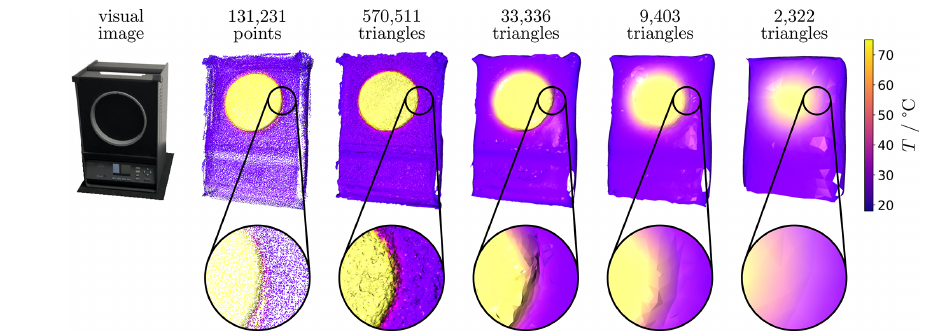
Figure 4. Visual image and different representations (point cloud and reconstructed surfaces with variable vertex reduction settings d red ) of the IR calibrator experiment 3D thermogram (rear side not shown but measured and available in 3D data).